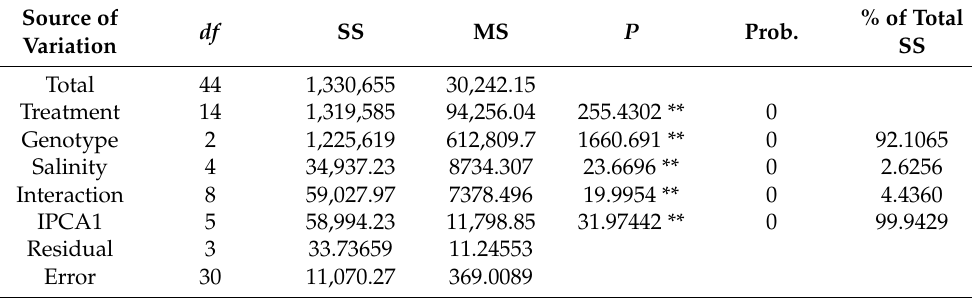
Table 3. AMMI analysis of antioxidant enzymes for different salinity